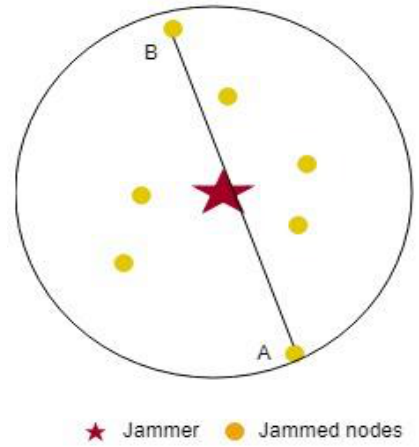
Figure 1. The maximum distance between two jammed nodes.